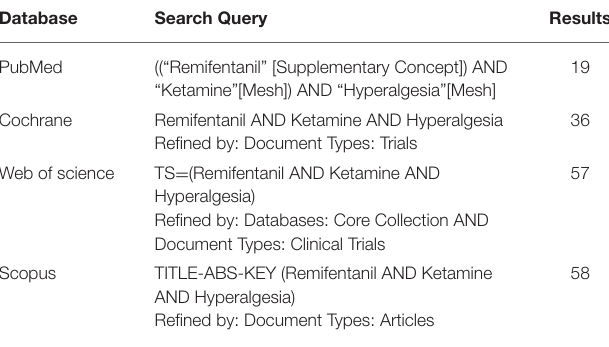
TABLE 1 | Search strategies and results in each bibliographic